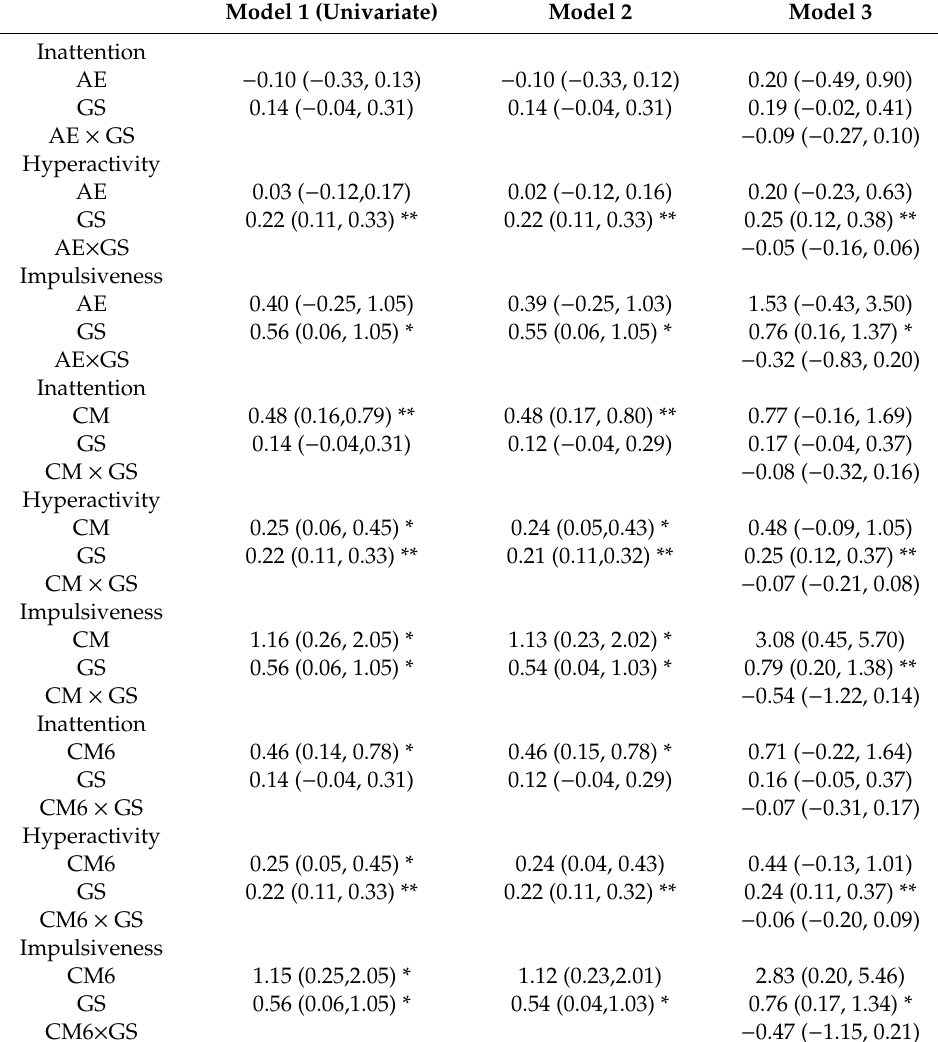
Table 3. E ff ects of genetic, environmental (childhood adversity) and gene-environment interaction on the outcome